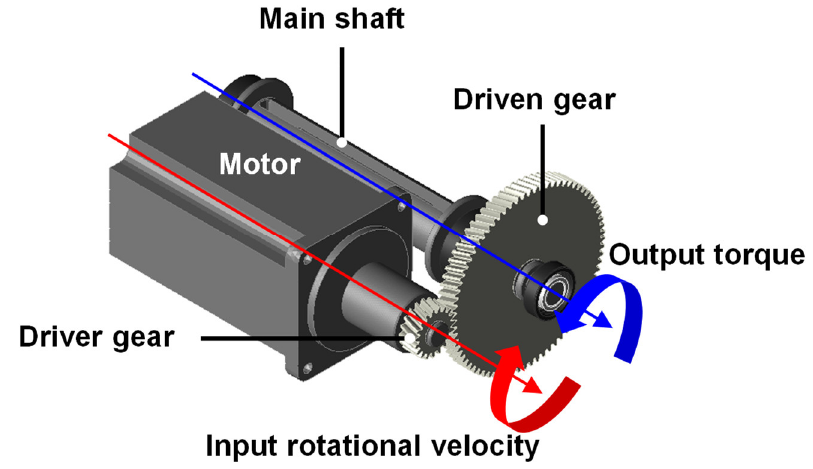
Figure 11. Gears rotation by the motor.